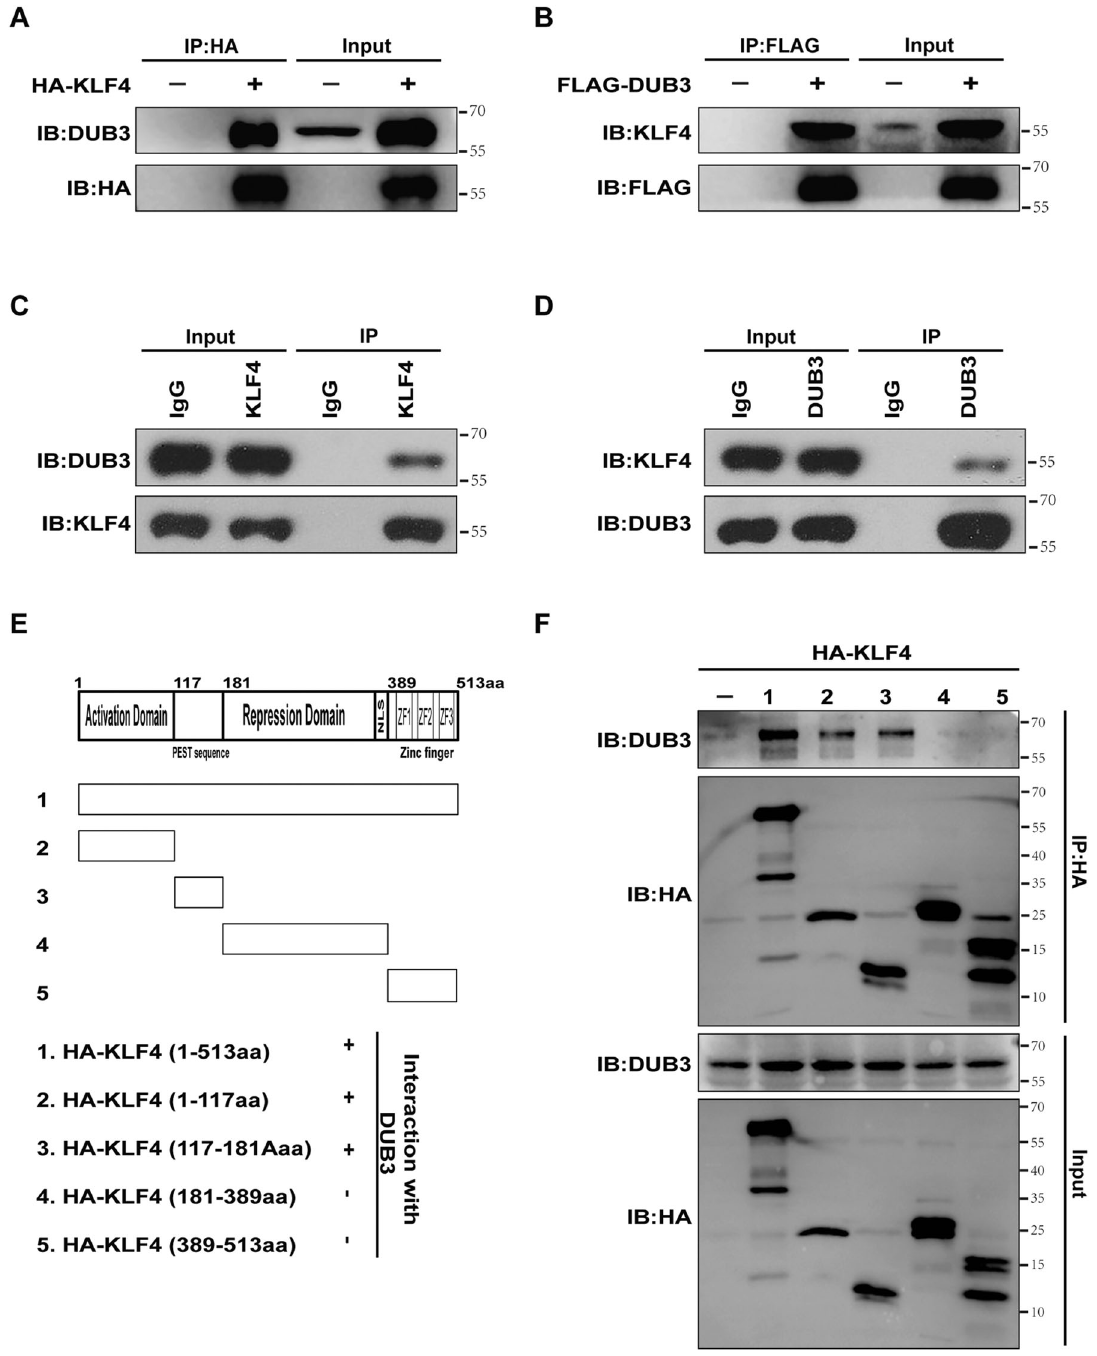
Fig. 2 Physical interaction between DUB3 and KLF4 proteins. A HEK293T cells were transfected with hemagglutinin (HA)-KLF4. Cell lysates were incubated with anti-HA-agarose, followed by Western blot analysis to detect DUB3 expression. B HEK293T cells were transfected with FLAG-DUB3. Cell lysates were incubated with anti-FLAG-agarose, followed by Western blot analysis to detect KLF4 expression. C , D Cell lysates of Hep3B cells were immunoprecipitated with control IgG, anti-KLF4, or anti-DUB3, as indicated, followed by Western blot analysis to detect DUB3 and KLF4 expression. E A schematic diagram of KLF4 domains and deletion mutations. F The plasmids expressing KLF mutants ( E ) were transfected into HEK293T cells. Cell lysates were incubated with anti-HA-agarose, followed by Western blot analysis to detect DUB3